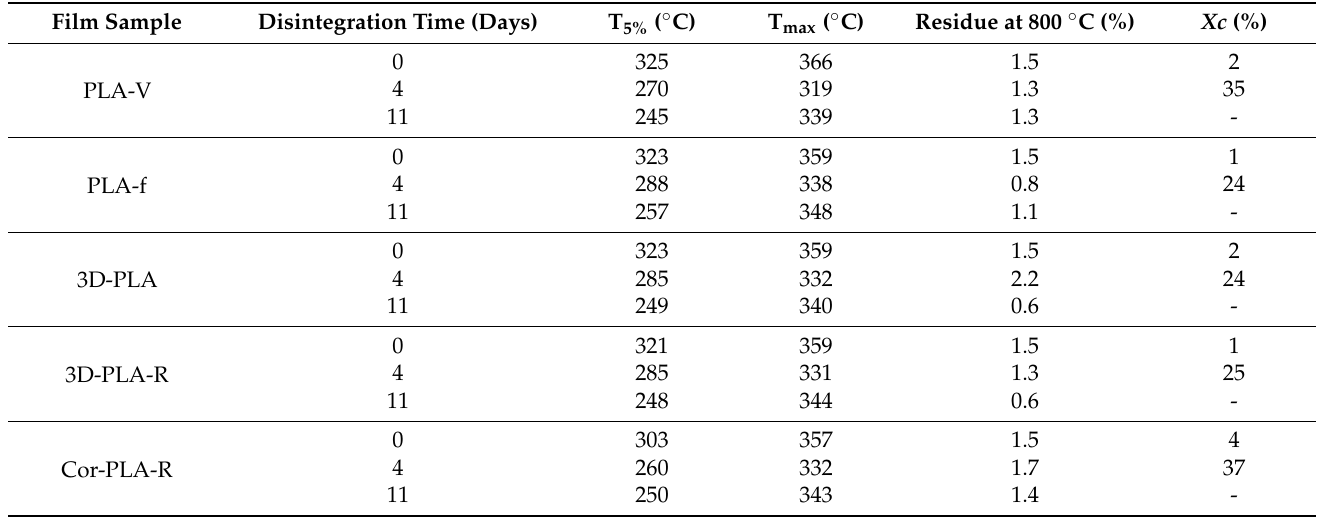
Table 4. TGA thermal parameters and degree of crystallinity determined by DSC for all films at different disintegration times. Film